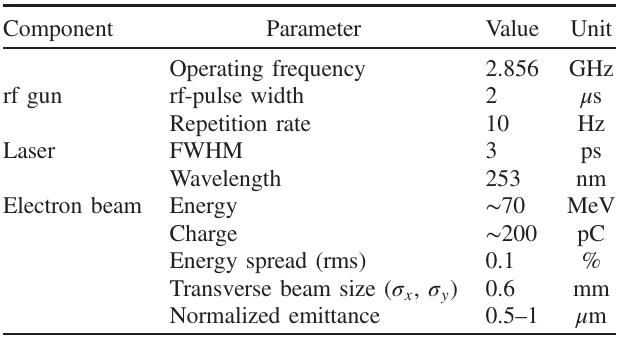
TABLE I. Summary of the ITF system and typical beam parameters used for this experiment.